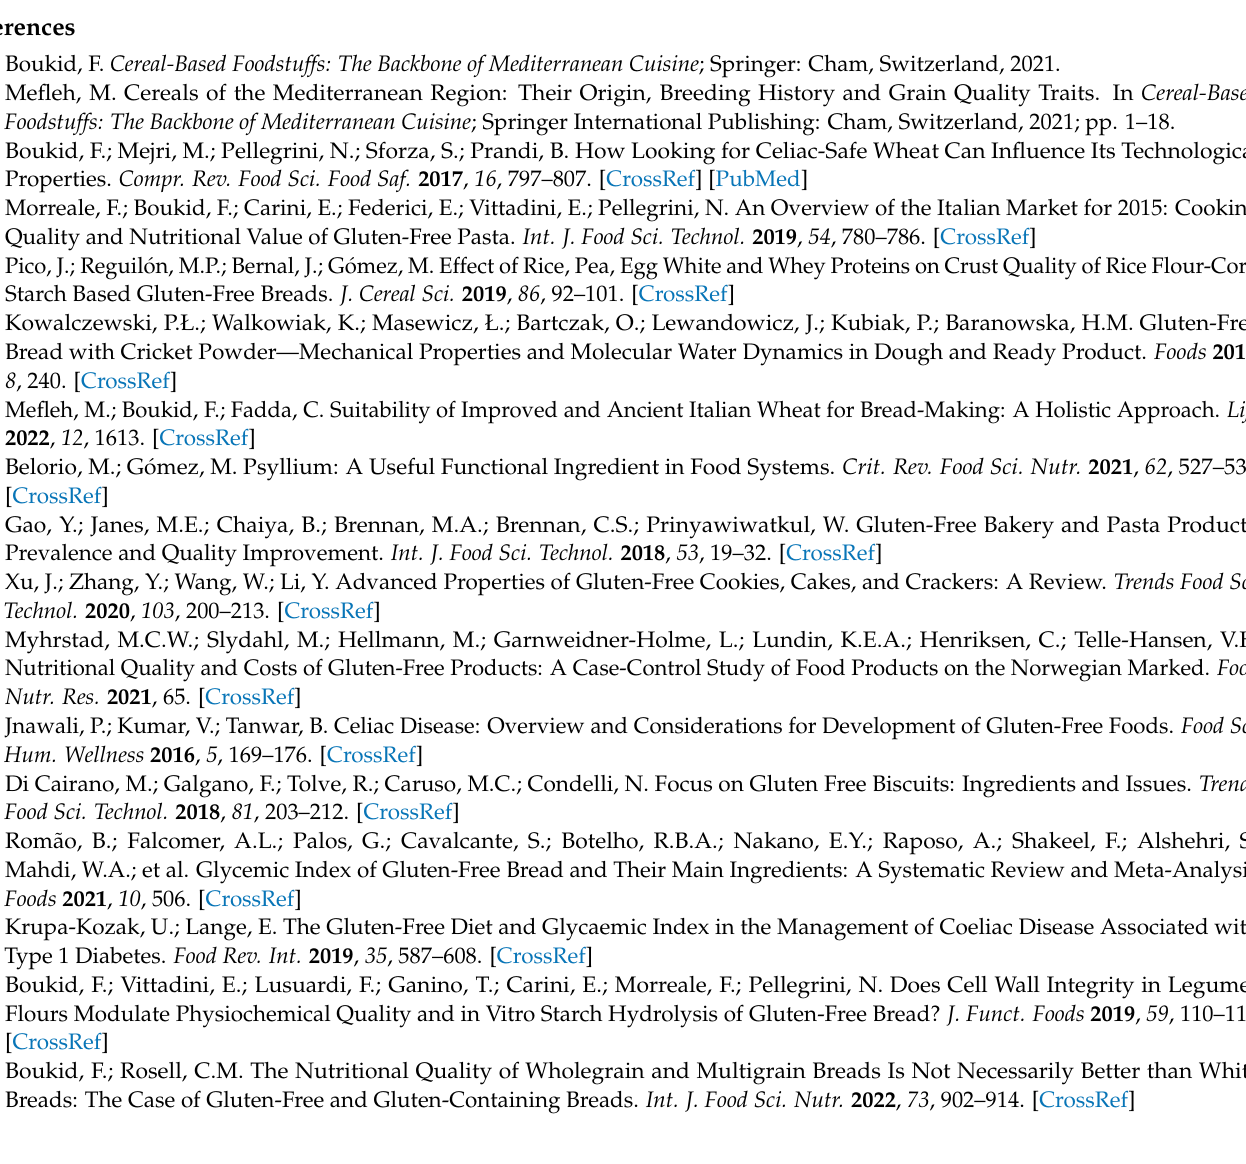
mixes; Table S2: List of ingredients of bread products; Table S3: List of ingredients of cakes, pastries, and sweet goods; Table S4: List of ingredients of savory biscuits and crackers; Table S5: List of ingredients of sweet biscuits and